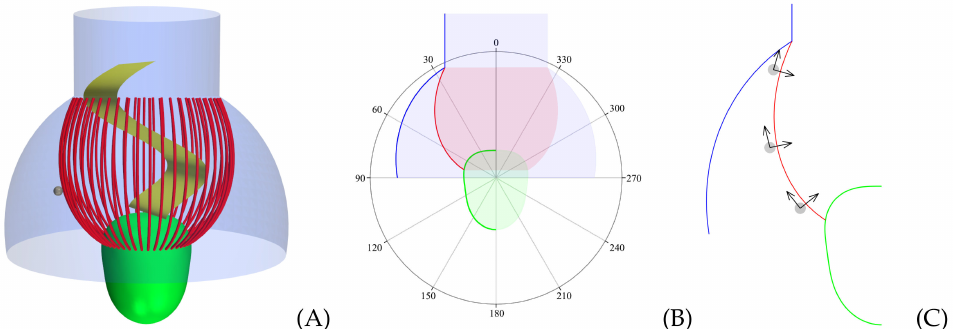
Figure 2. ( A ) The 3D computational fluid dynamics (CFD) model morphology, shown with a 5 µ m wide flagellar vane (yellow) and a medium-sized prey (gray). ( B ) A 2D schematic of the CFD model. The bold curves, which correspond to Equations (2) and (3), are revolved around the longitudinal center axis to create the model surfaces (pictured as opaque). The polar coordinate system, which is shown in degrees, serves as the reference frame for the prey’s placement along the filter collar. ( C ) The three vertical prey positions on the collar. Each prey (gray) is equipped with a local coordinate system: normal ( x ) and tangent ( y ) to the collar surface. Pictured is a medium-sized prey (gray) in true relative